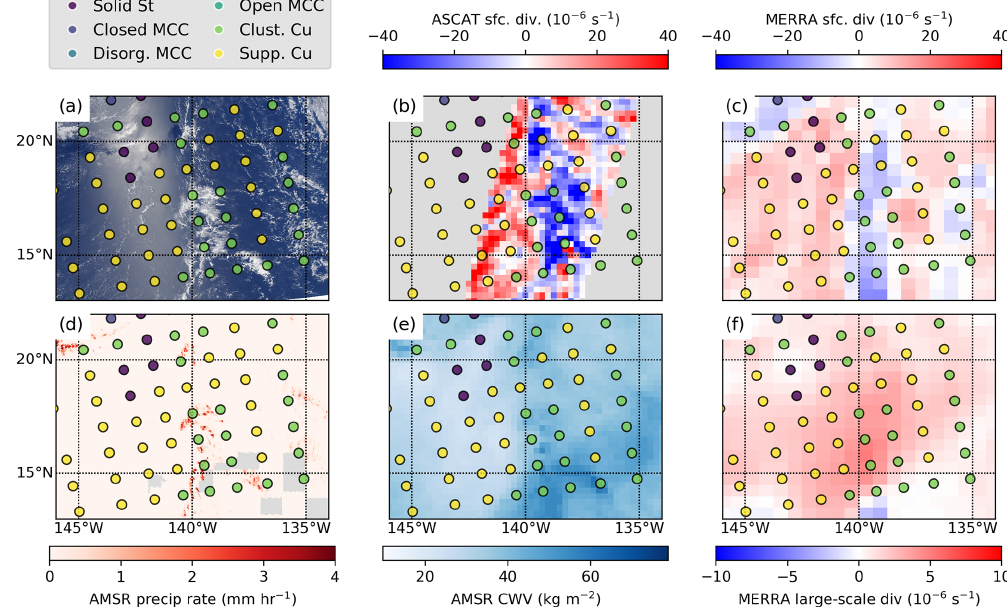
Figure 7. Sample region observed on 22 July 2015 showing classifications (every panel, in colored circles). (a) MODIS true-color reflectance, (b) ASCAT surface divergence, (c) MERRA-2 surface divergence, (d) AMSR-2 89Ghz precipitation rate, (e) AMSR-2 column water vapor, (f) MERRA-2 700hPa